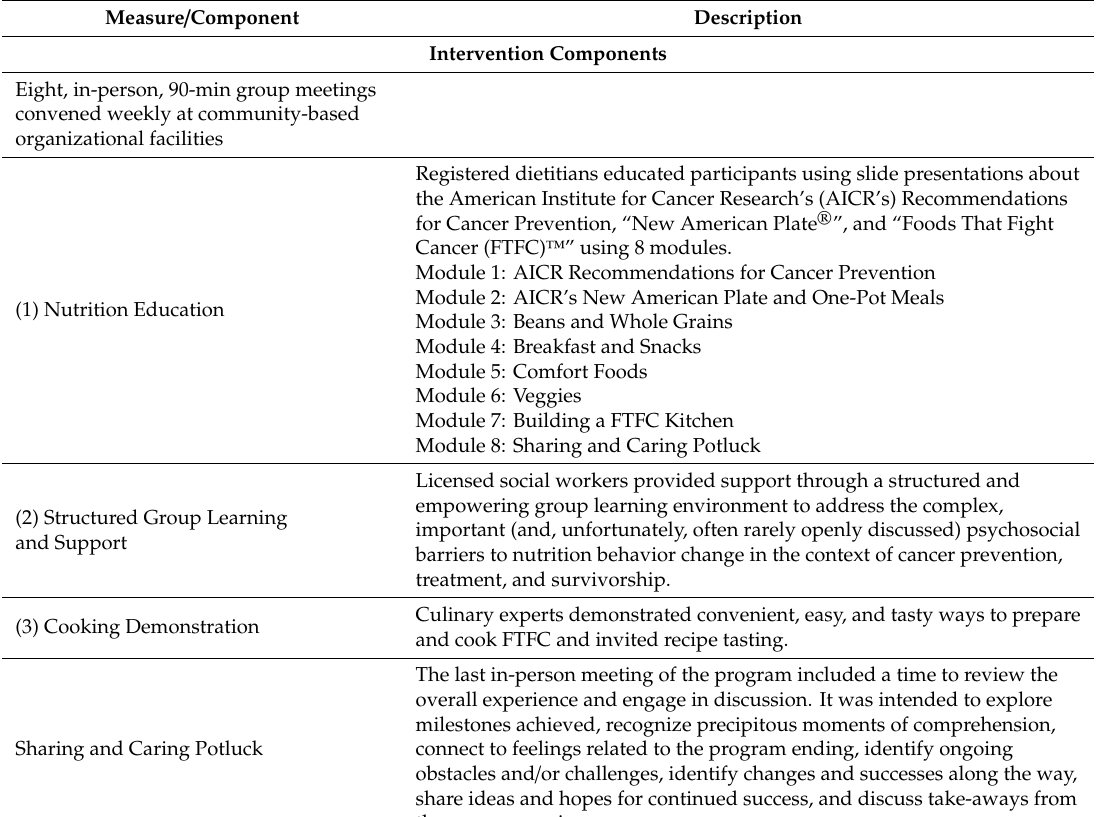
Table1. Descriptionofinterventioncomponentsandoutcomemeasuresusedinarandomizedcontrolled trial of Coping with Cancer in the Kitchen, a Nutrition Education Program for Cancer